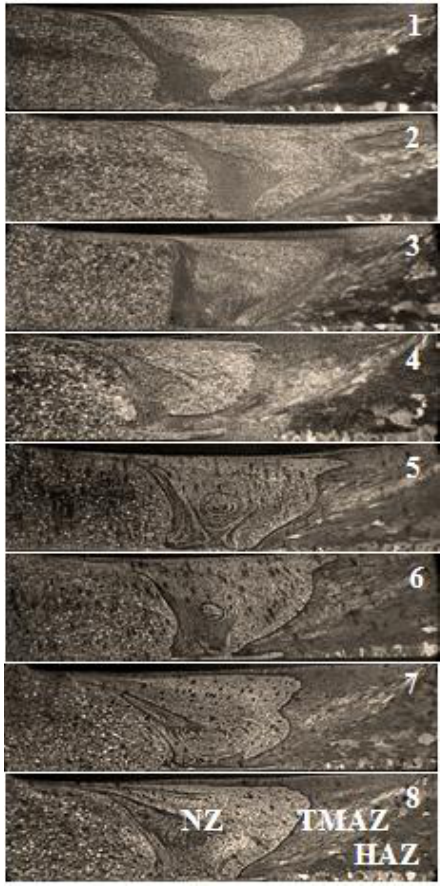
Figure 3. Cross-section of each weld joint.